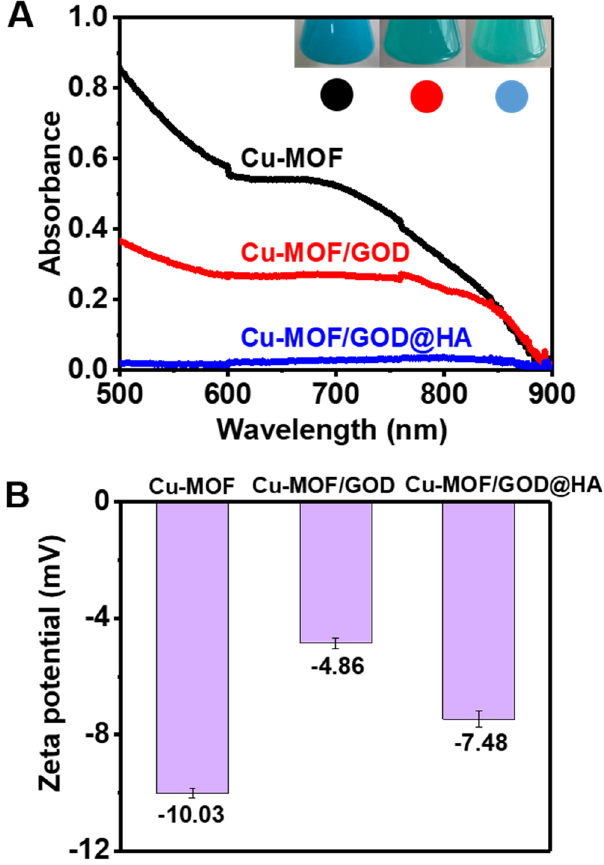
Figure 3. ( A ) UV-vis absorption spectra of Cu-MOF, Cu-MOF/GOD and Cu-MOF/GOD@HA (The concentrations of pending test samples were 100 μ g mL –1 ). Inset in ( A ) shows the photographs of the solutions containing Cu-MOF, Cu-MOF/GOD and Cu-MOF/GOD@HA. ( B ) Zeta potential values of Cu-MOF, Cu-MOF/GOD and Cu-MOF/GOD@HA. (The concentrations of pending test samples are 200 μ g mL –1 ).